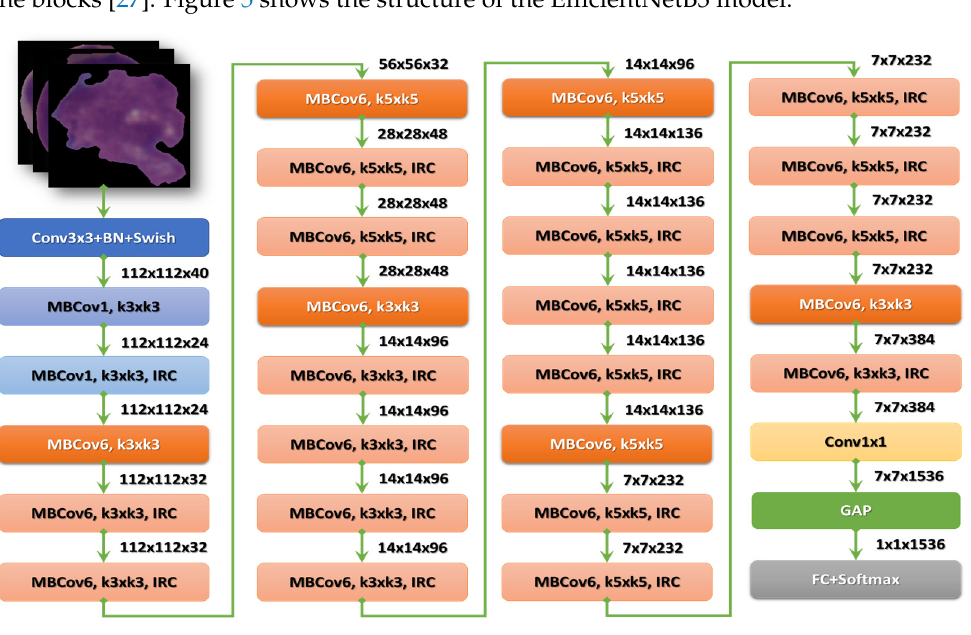
Figure 5. The structure of the EfficientNet-B3 model.